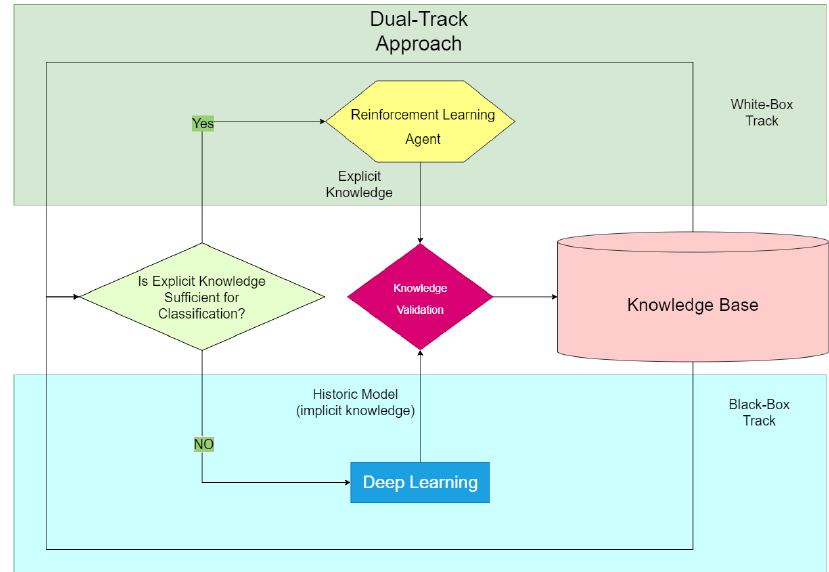
Figure 2. Dual-track fine-grained sentiment